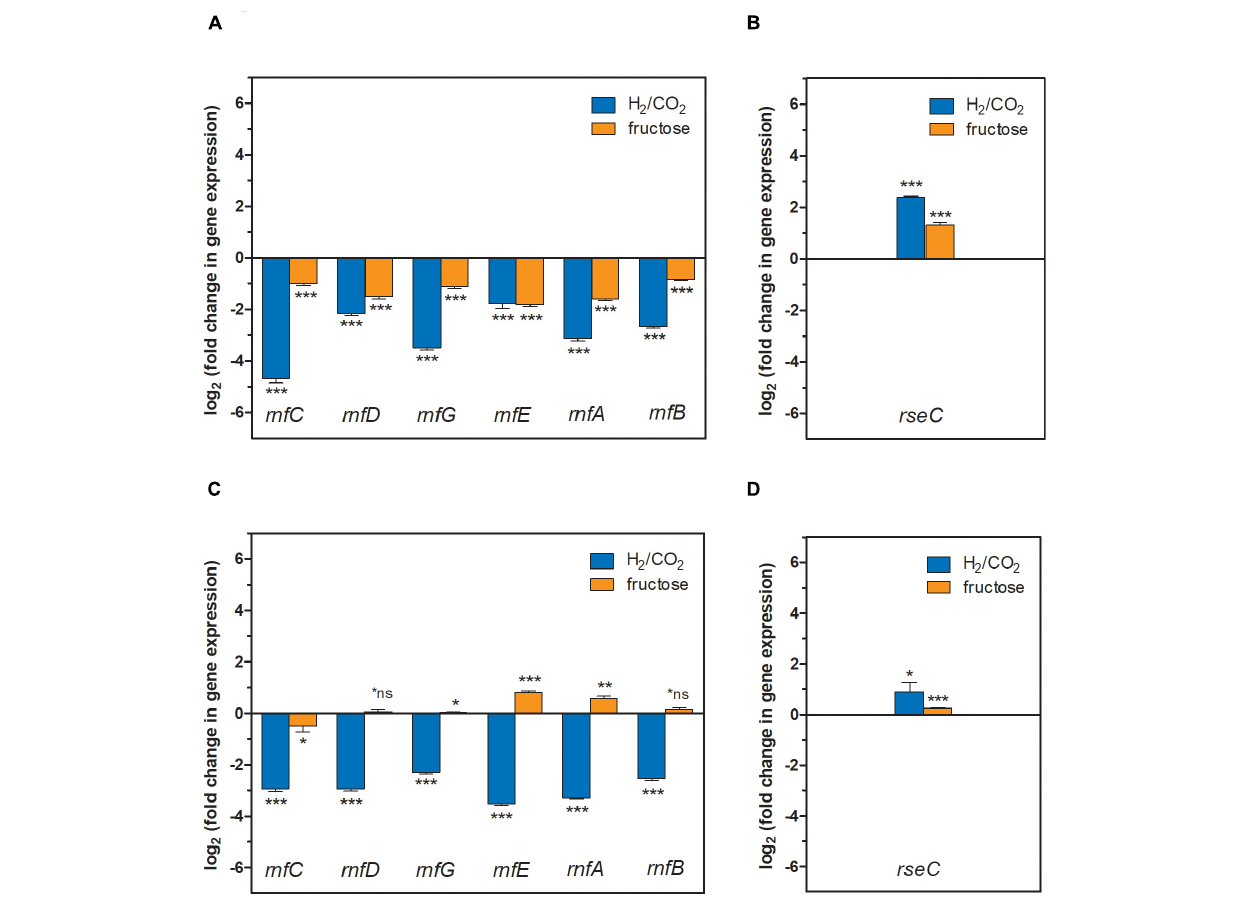
FIGURE 3 | Gene expression change of the rnfCDGEAB cluster genes and the rseC gene in the (cid:49) RNF and (cid:49) rseC deletion strains. (A) Gene expression change for the genes rnfC , rnfD , rnfG , rnfE , rnfA , and rnfB in strain C. ljungdahlii (cid:49) rseC after 3 h cultivation time; (B) gene expression change for the gene rseC in strain C. ljungdahlii (cid:49) RNF after 3 h cultivation time; (C) gene expression change for the genes rnfC , rnfD , rnfG , rnfE , rnfA , and rnfB in strain C. ljungdahlii (cid:49) rseC after 20 h cultivation time; and (D) gene expression change for the gene rseC in strain C. ljungdahlii (cid:49) RNF after 20 h cultivation time. RNA samples were purified from cultures that were cultivated either autotrophically with hydrogen and carbon dioxide (blue bars) or heterotrophically with fructose (orange bars). cDNA was synthesized from the purified RNA samples and used as template for qRT-PCR analyses. The individual gene expression profiles of each gene was calculated using the wild-type strain as reference, which was grown under the same conditions. The rho gene was used as “housekeeping” gene. The fold change in gene expression was determined with the 2 − (cid:49)(cid:49) CT method (Livak and Schmittgen, 2001). *** P ≤ 0.001; ** P ≤ 0.01; * P ≤ 0.05; *ns, not significant ( P > 0.05). We defined log 2 (fc) ≤ –2 as downregulated genes and ≥ + 2 as upregulated genes.